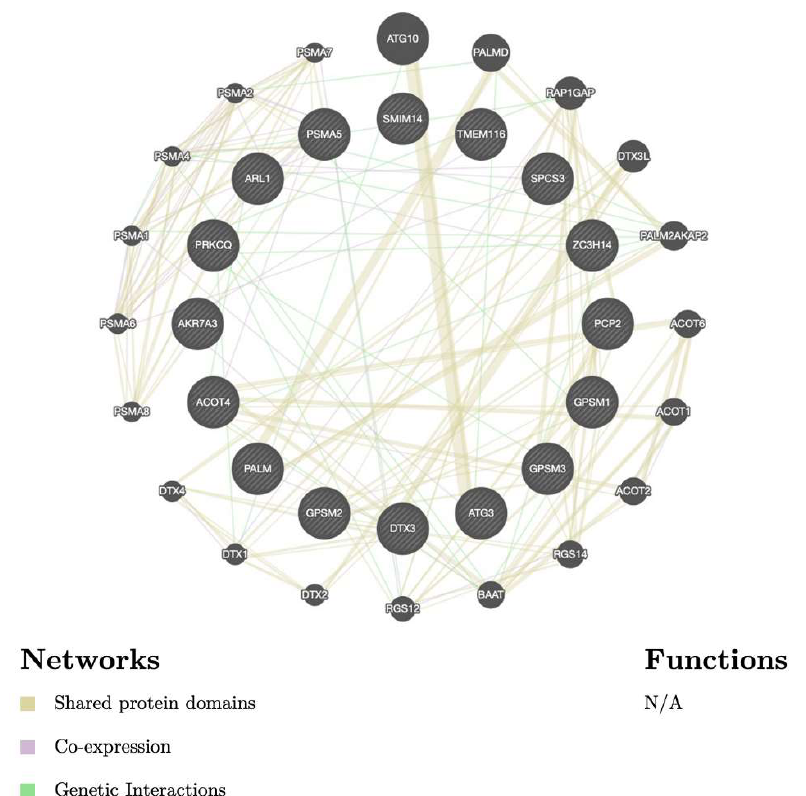
Figure 6. Gene–gene interaction network of GPSMs in breast cancer (GeneMANIA). Nodes represent genes, nodal sizes indicate interaction strengths, and line colors represent types of interactions.